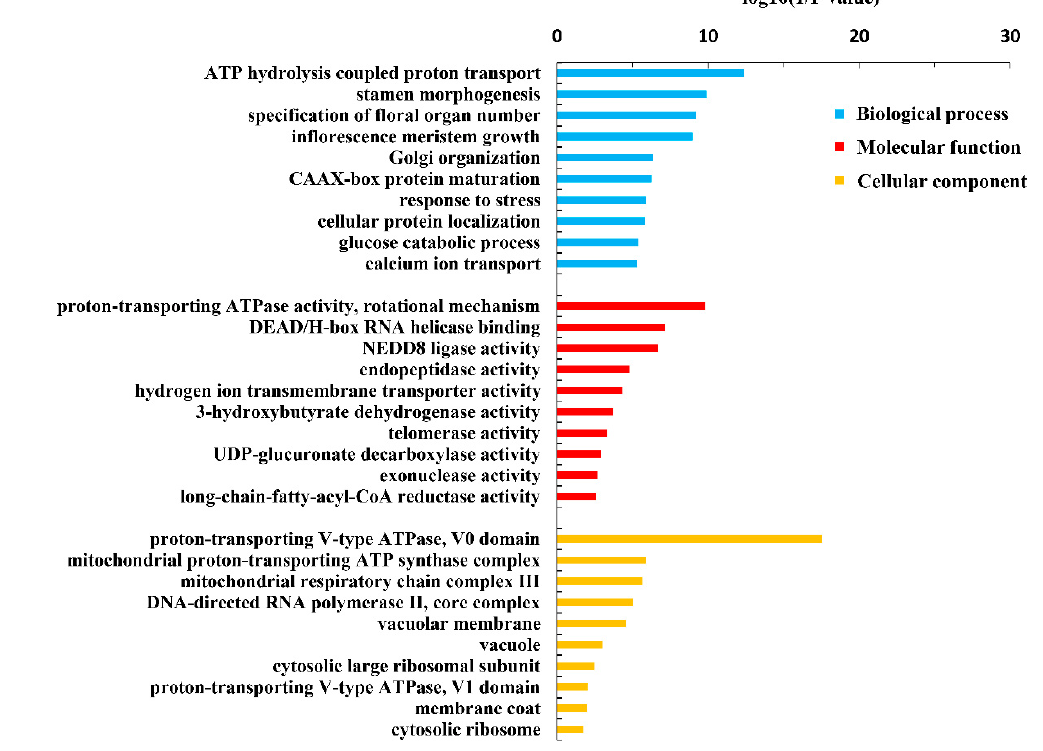
Figure 2. GO terms of the functional categorization of the same novel genes in the root, old leaves and juvenile leaves of B. napus cultivars Qingyou10 (QY10) or Westar10 (W10) under boron sufficient and deficient conditions.